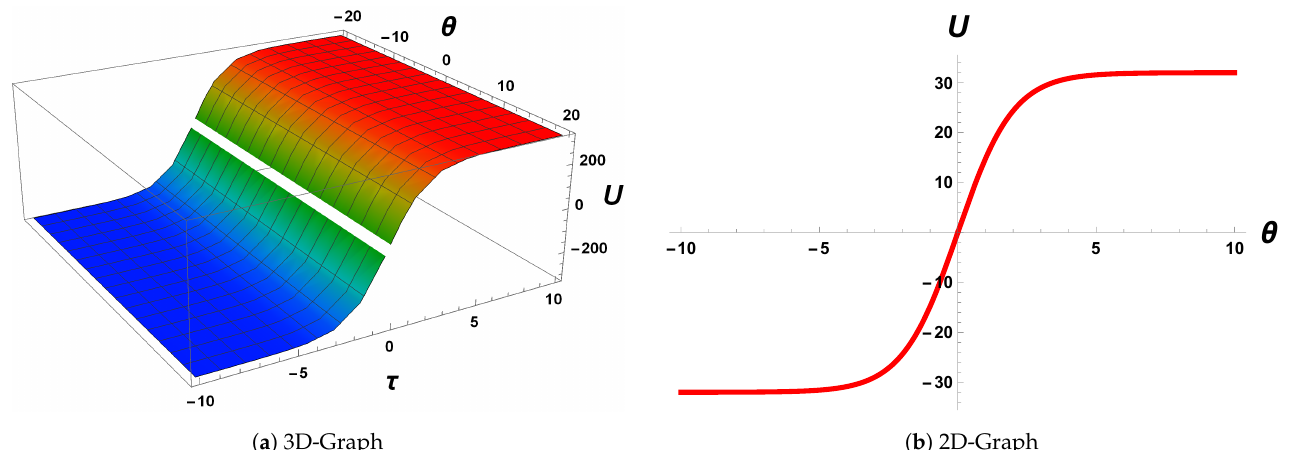
Figure 9. Diagrams a − 3 D and b − 2 D representation of U 19 ( θ , τ ) for l 1 = 1, l 1 = 1.5, l 2 = 0.75, δ = 0.1, γ 1 = 0.1, γ 2 = 0.15, and γ 3 = 1.2.